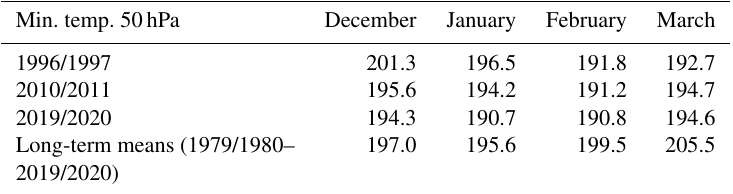
Table 1. Minimum temperatures (in kelvin) of the polar cap region (50–90 ◦ N) at 50hPa (about 20km altitude) based on the monthly mean temperatures from ERA5 in December, January, February, and March of 1996/1997, 2010/2011, and 2019/2020 and the long-term mean values (1979/1980–2019/2020),